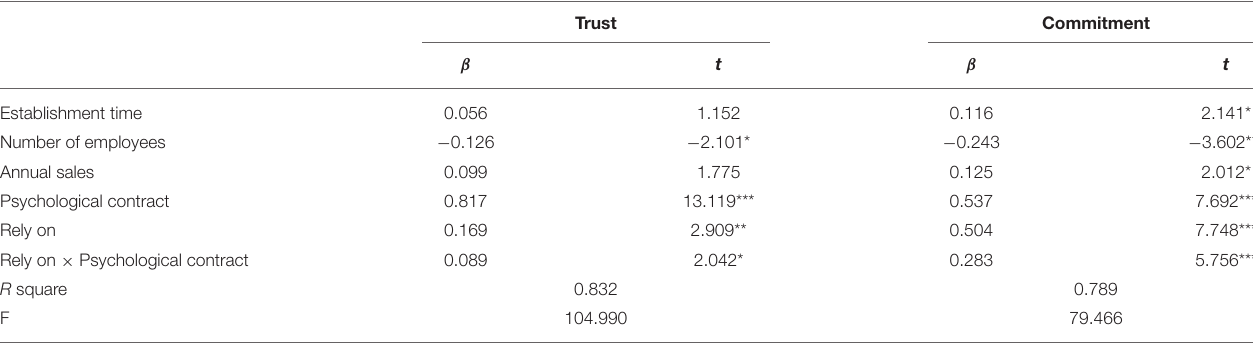
TABLE 6 | Regression analysis results of dependent regulatory